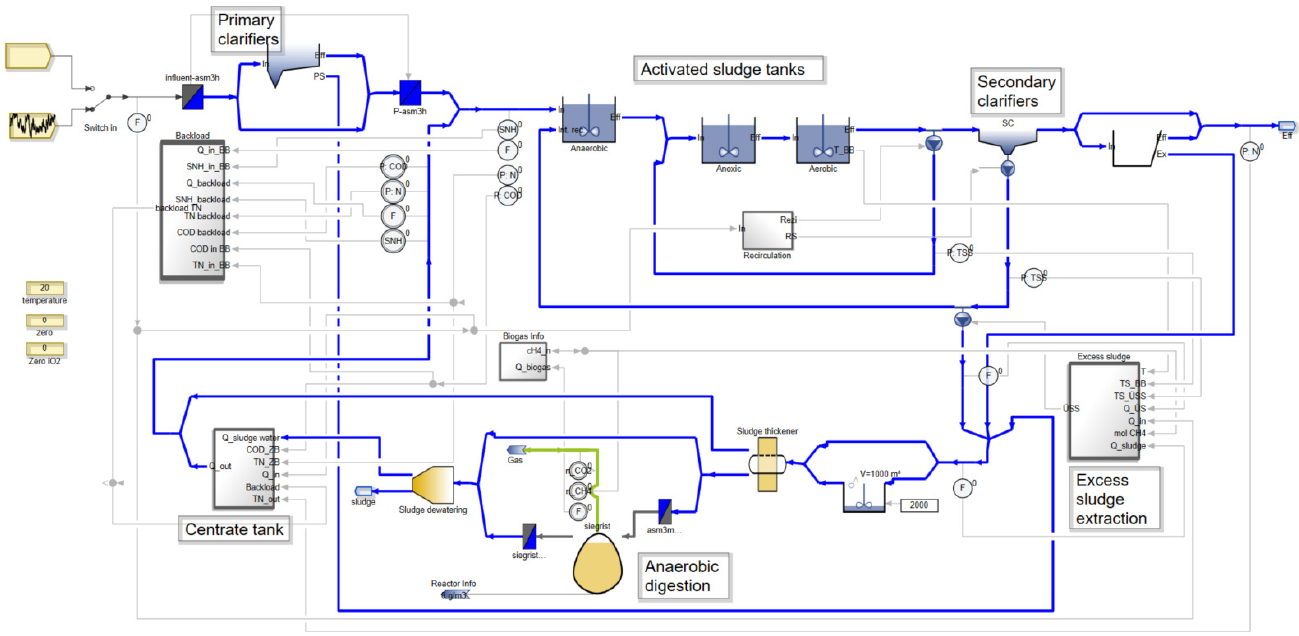
Figure 2. Model of the example WWTP with anaerobic sludge stabilization in SIMBA. The sludge extraction (excess sludge) is adjusted automatically to obtain the target sludge age according to Equation (1), based on the variable wastewater temperature, which fluctuates between 10 and 24 ◦